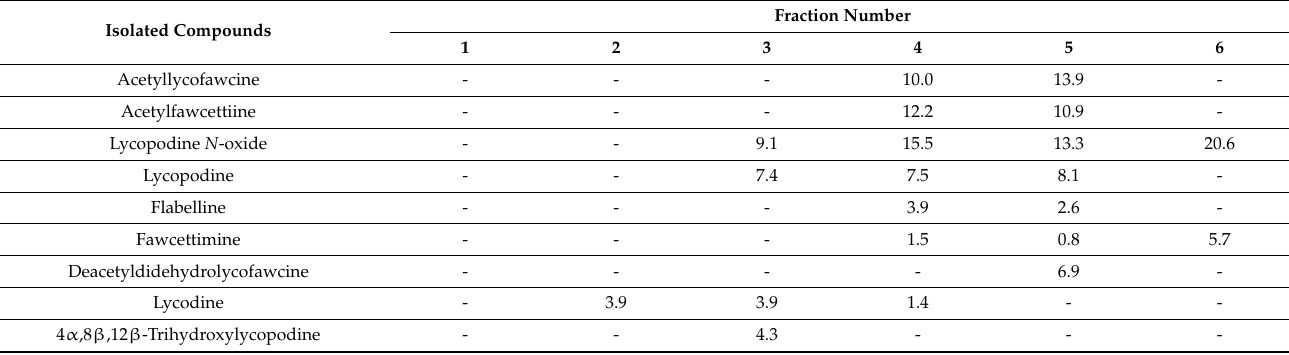
Table 7. Results of alkaloids identified via HPLC/ESI-QTOF-MS present in fractions 1–6 obtained from experiment 1 via VLC using sorbents Al 2 O 3 and silica gel in ratio 1:3 from L. clavatum extract. Isolated